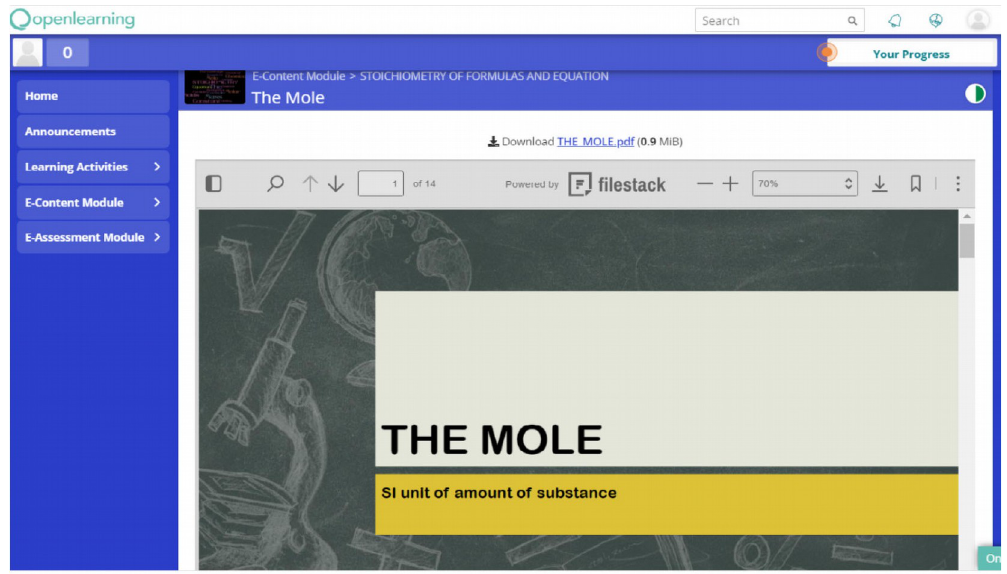
Figure 10. An example of notes in PowerPoint